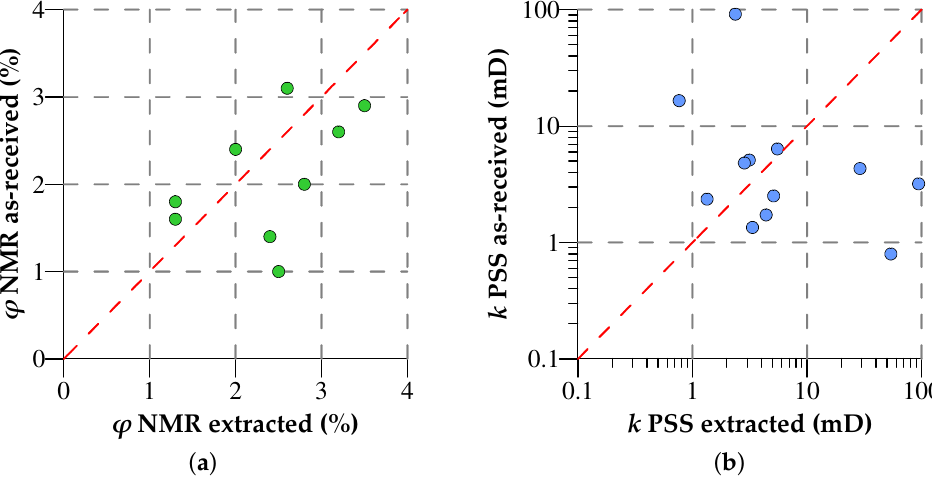
Figure 6. NMR porosity ( a ) and pseudo-steady-state permeability (PSS) (Darcypress) permeability ( b ) for the as-received versus extracted samples.